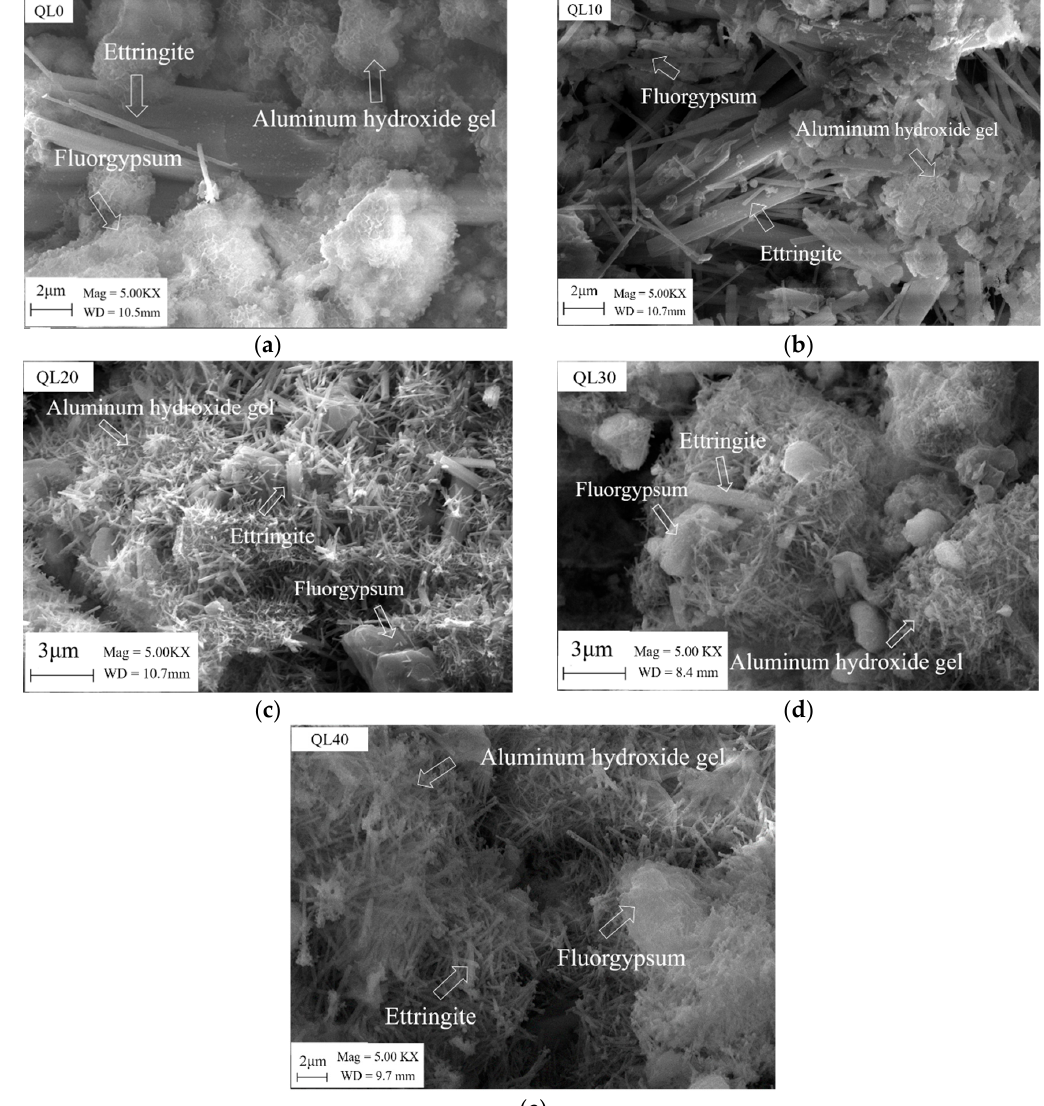
Figure 18. SEM images of double liquid grouting material with different quicklime contents at 28 days: ( a ) 0%; ( b ) 10%; ( c ) 20%; ( d ) 30%; ( e ) 40%.